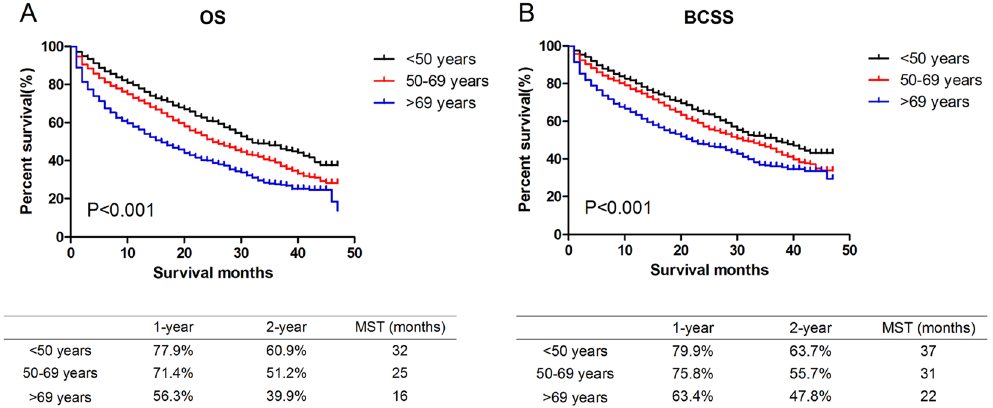
Figure 1. Comparison of survival in younger, middle-aged and elder metastatic breast cancer patients. Kaplan Meier analysis for overall survival (OS, χ 2 = 121.9, P < 0.001, Fig. 1A) and breast cancer-specific survival (BCSS, χ 2 = 69.8, P < 0.001, Fig. 1B) were shown in the graph. The prognosis became worse with the increase of age. The 1-year, 2-year survival rate and median survival time (MST) were listed respectively in the table below the